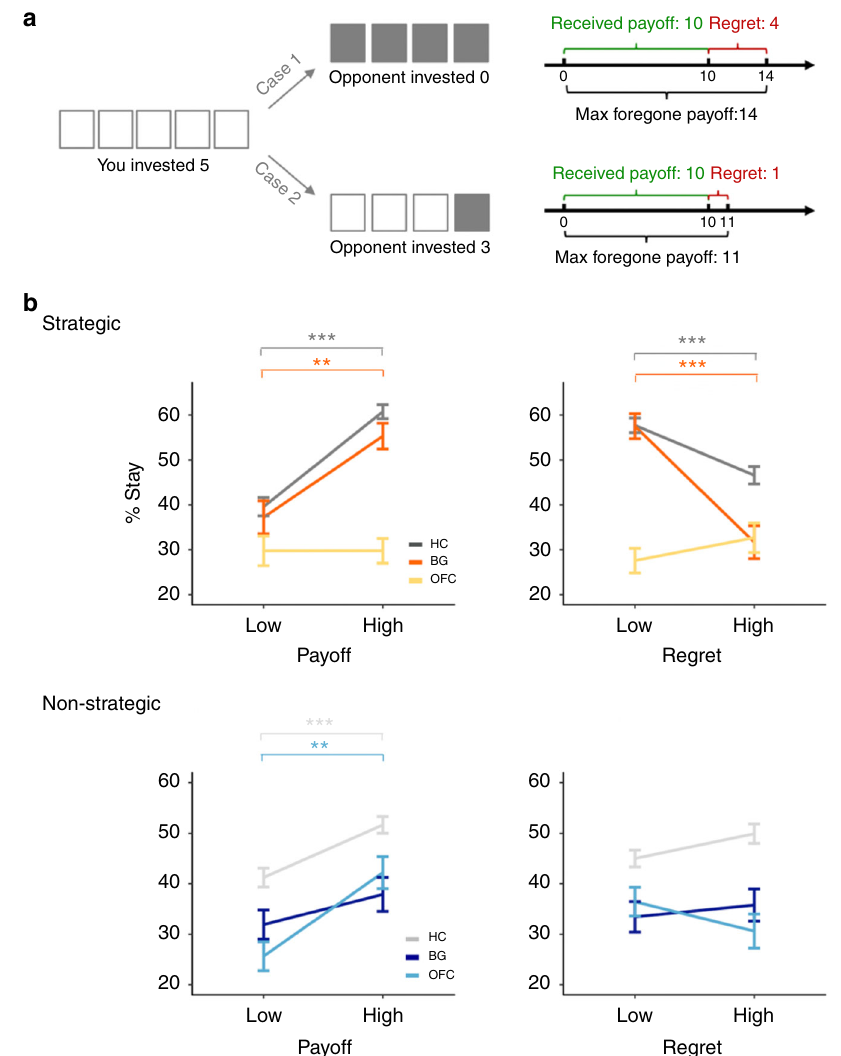
Fig. 2 Overall task performances. a Illustration for the received and forgone payoff. The received payoff re fl ects the amount of reward obtained through the action chosen by the subject, whereas the maximal forgone payoff re fl ects the amount of reward one could have received by choosing the best available action given the opponent ’ s decision. For example, if the subject chose 5 and the opponent 0, the maximal forgone payoff was 14, as the optimal action would have been to invest 1, as opposed to the received payoff 10. Had the opponent chosen 3, however, the received payoff would remain to be 10 but the maximal payoff would be 11, as choosing 4 would have been the best strategy. Thus, the maximal forgone payoff re fl ects the variability in opponents ’ actions and their effects on possible outcomes. Following previous studies, regret is de fi ned as the distance between the maximal forgone and received payoff, given the opponent ’ s decision on a particular trial. b Stay/switch frequency versus received payoff (left) or regret (right). Y -axes represent the percentage of trials in which subjects chose to stay with the same decision on the next trial (i.e., “ stay ” ), based on median splits on payoffs and regrets for each cohort and condition ( x -axes). Error bars represent S.E.M. * P < 0.05, ** P < 0.01, *** P < 0.001, Bonferroni